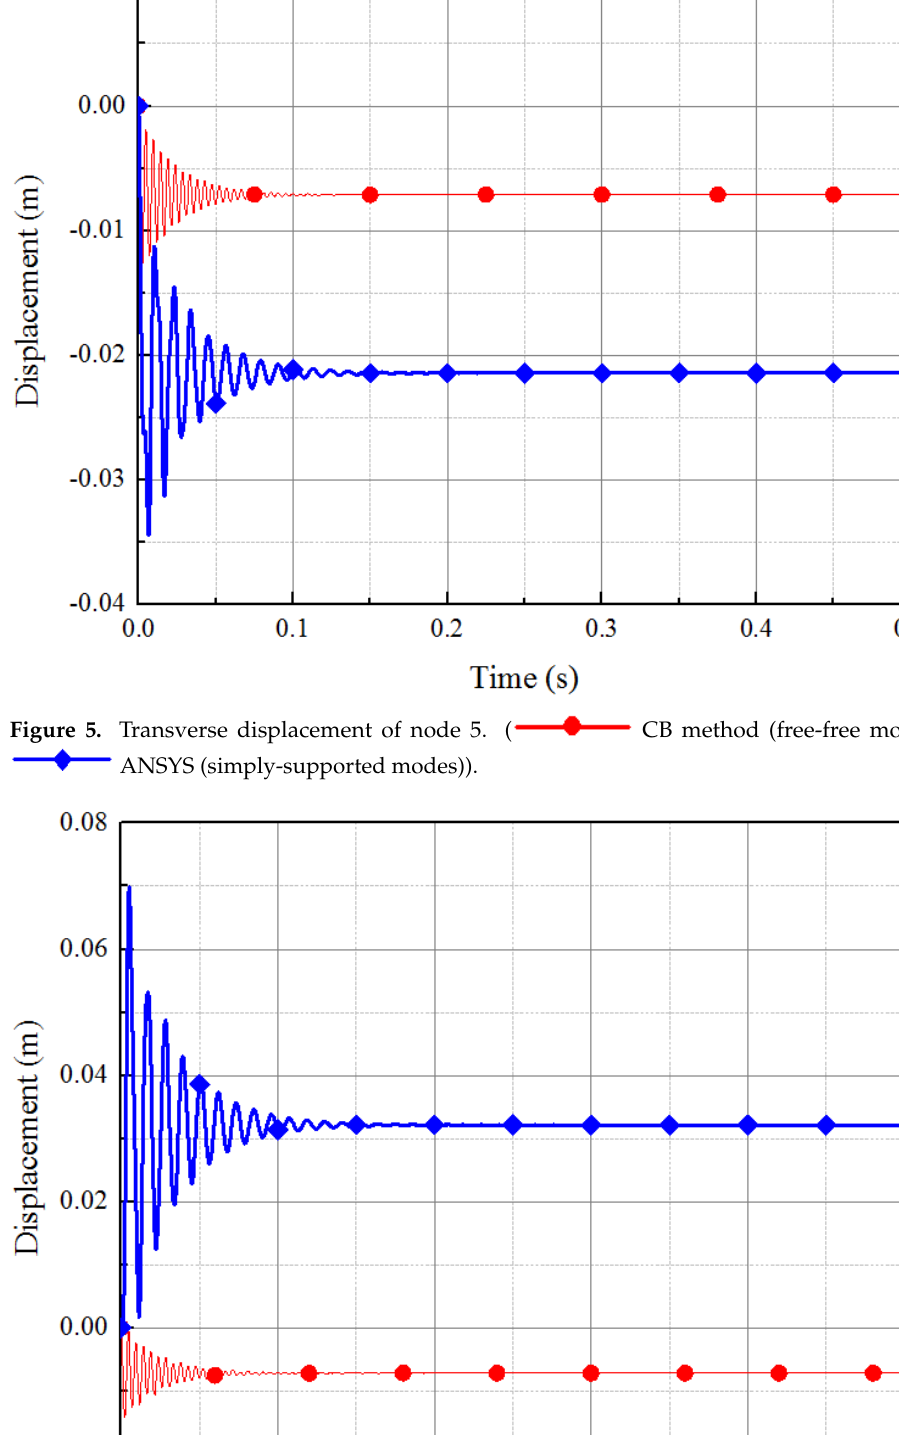
CB method (free-free modes)